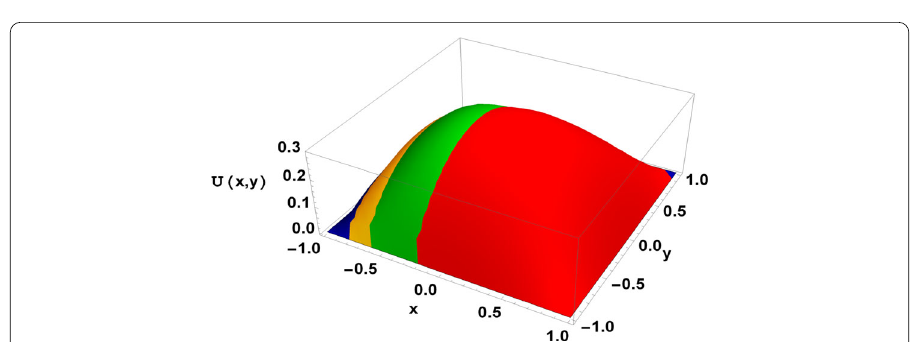
Figure 5 3D graph for the velocity profile with various Hartmann number